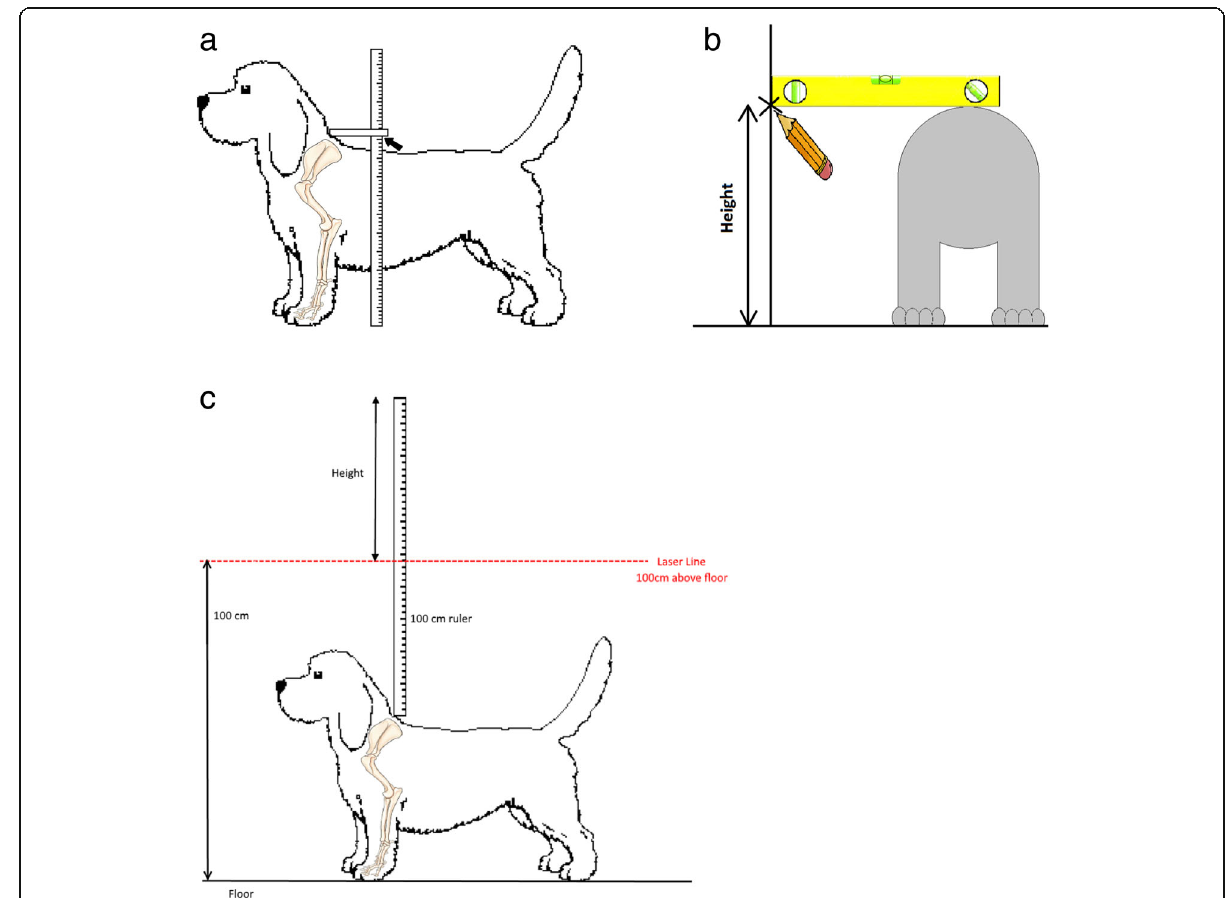
Fig. 4 (Additional files 1 and 2). Methods of measuring the height of dogs. a . Use of a commercially available measuring stick to measure the height at the withers. b . Use of a wall as an aid for measurement of the height at the withers, when a commercially available measuring stick is not available. c . Use of the laser method for measuring the height of a dog at the